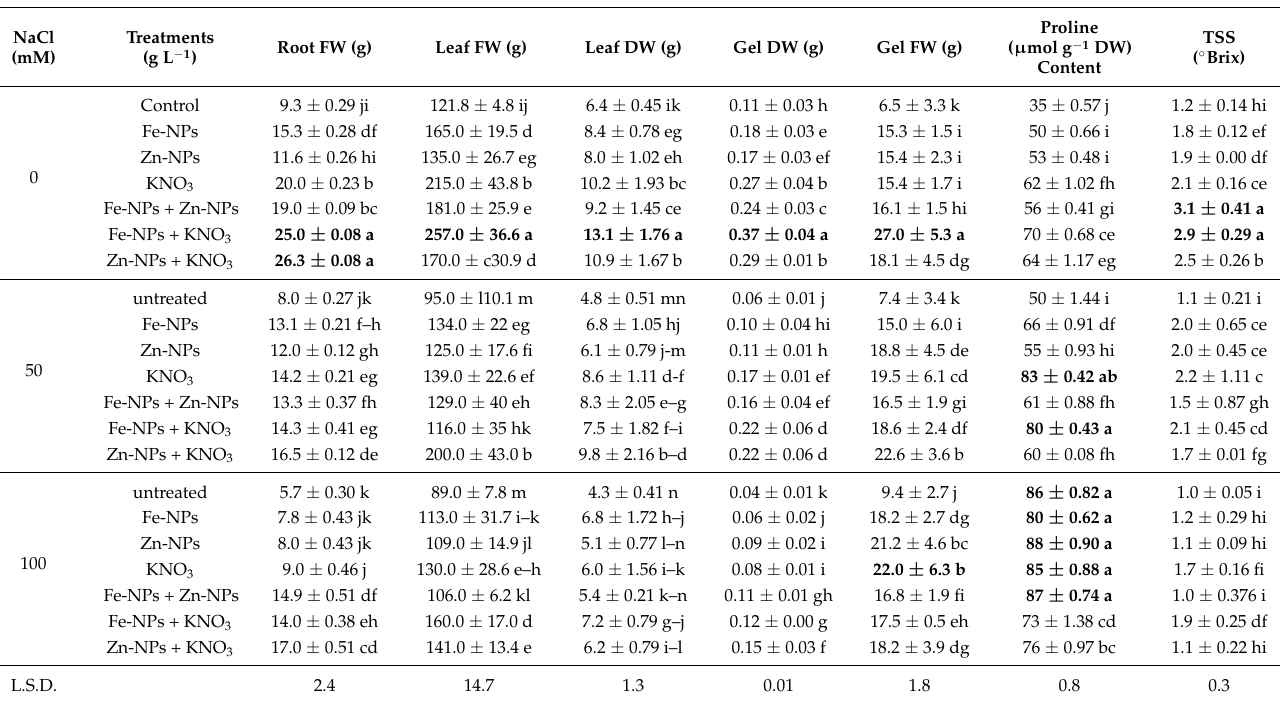
Table 2. Effect of salinity levels and foliar applications on plant weight, gel weight, proline content, and TSS content of Aloe vera